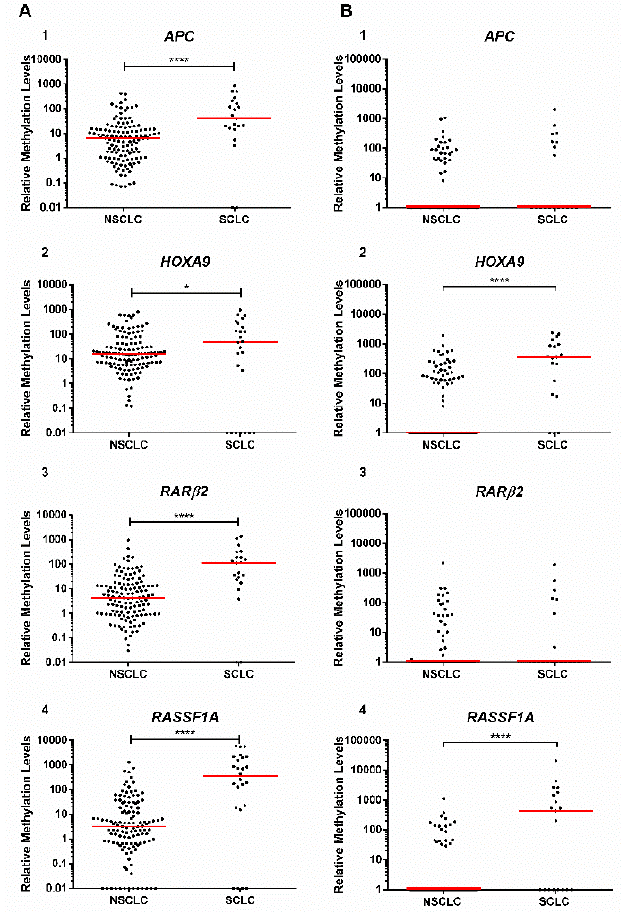
Figure 2. Scatter plot of ( A ) (1) APC , (2) HOXA9 , (3) RAR β 2, and (4) RASSF1A methylation level distributions among major lung cancer (LCa) subtypes (non-small-cell lung cancer (NSCLC) and small-cell lung cancer (SCLC)) in study group #1 (tissue samples) and ( B ) (1) APC (number of values that fall in the x axis: NSCLC = 82, SCLC = 11), (2) HOXA9 (number of values that fall in the x axis: NSCLC = 68, SCLC = 3), (3) RAR β 2 (number of values that fall in the x axis: NSCLC = 84, SCLC = 12), and (4) RASSF1A (number of values that fall in the x axis: NSCLC = 90, SCLC = 8) among NSCLC and SCLC in study group #2 (plasma samples). Mann–Whitney U test. * p < 0.05 and **** p < 0.0001. Red horizontal line represents the median methylation level.